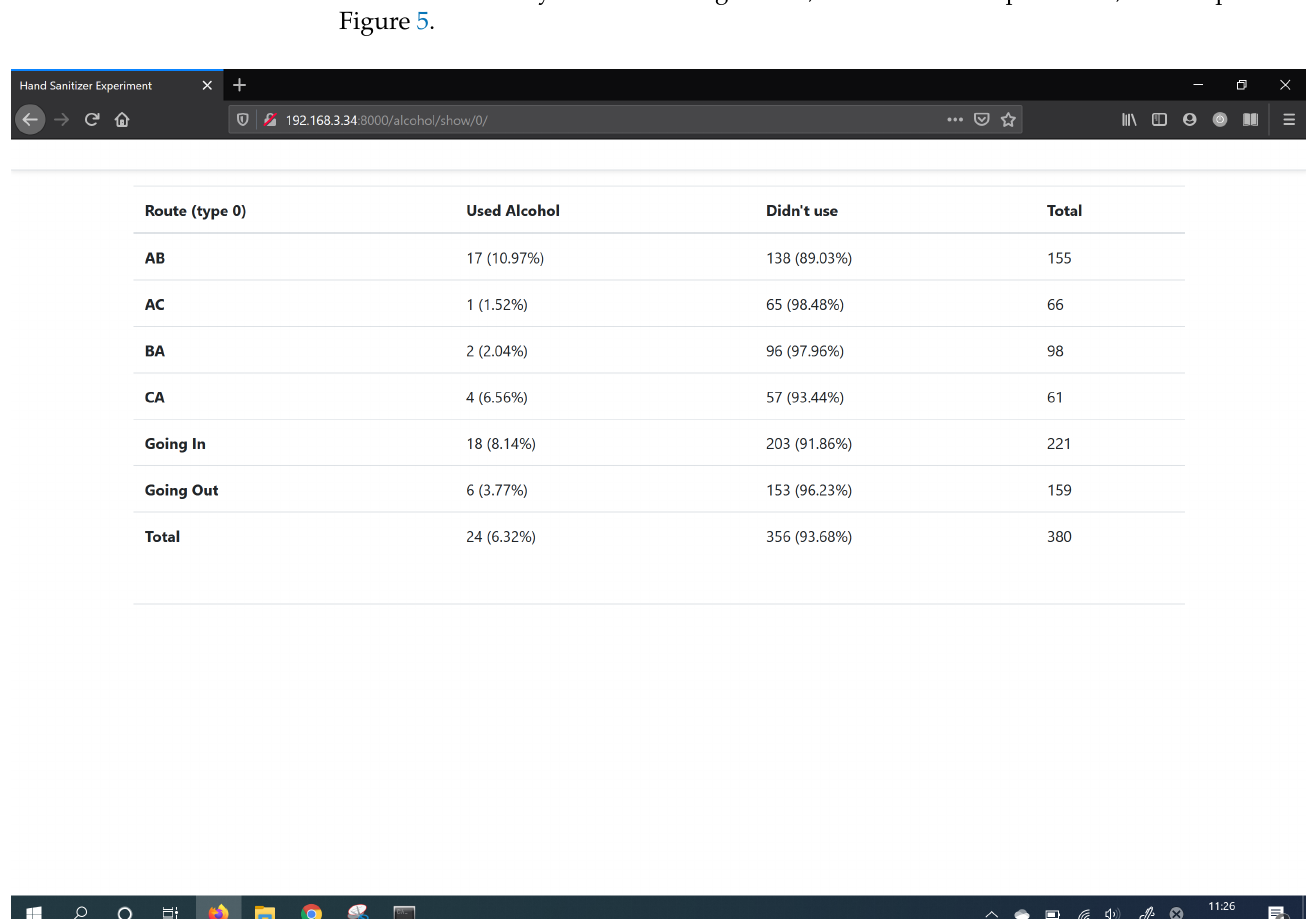
Figure 5. Example of the user interface of the website to analyze data from each